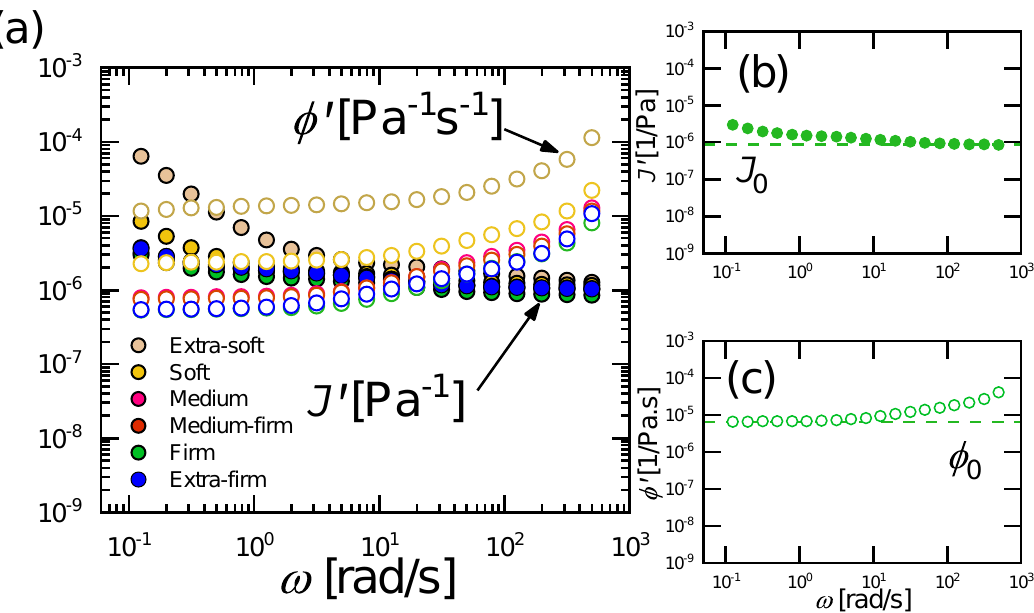
Figure 9: Stress-input paradigm of linear viscoelastic functions. Elastic ( J ′ , closed) and viscous ( ϕ ′ , open) measures for the therapy put- ties in the stress-input paradigm. Both measures show a plateau (low-frequency for ϕ ′ , high-frequency for J ′ ) when viewed from the stress-input perspective. The elastic plateau converges to the same value for all putties. Right: stress-input measurements for the “firm” viscoleastic therapy putty. Low-dimensional viscoelastic descriptions for the elastic ( J 0 ) and viscous ( ϕ 0 ) measures are easily found as the data plateaus over multiple decades of input frequencies in this stress-input